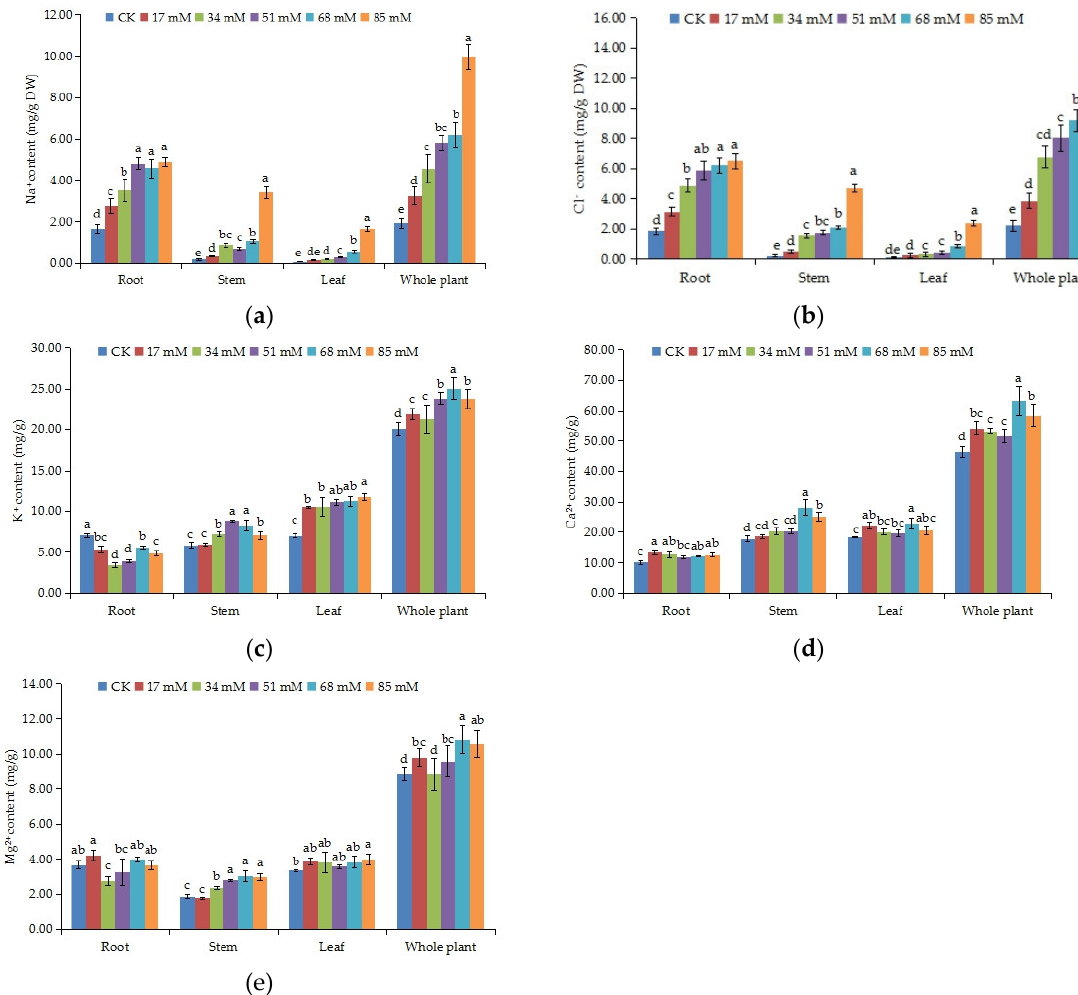
Figure 3. Effects of increasing levels of soil salinity on the Na + ( a ), Cl − ( b ), K + ( c ), Ca 2+ ( d ) and Mg 2+ ( e ) content in root, stem, leaf, and whole plant of C. turczaninowii seedlings after 42 days. Different lowercase letters indicate significant differences among treatments ( p < 0.05), n = 3.